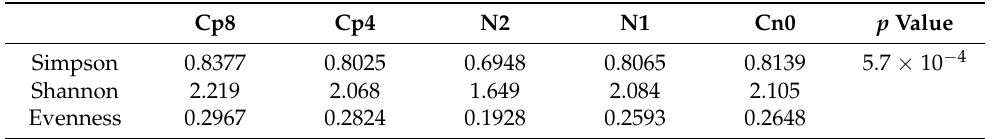
Table 1. Diversity indexes of chemotaxis genes within the fertilized and unfertilized soils from